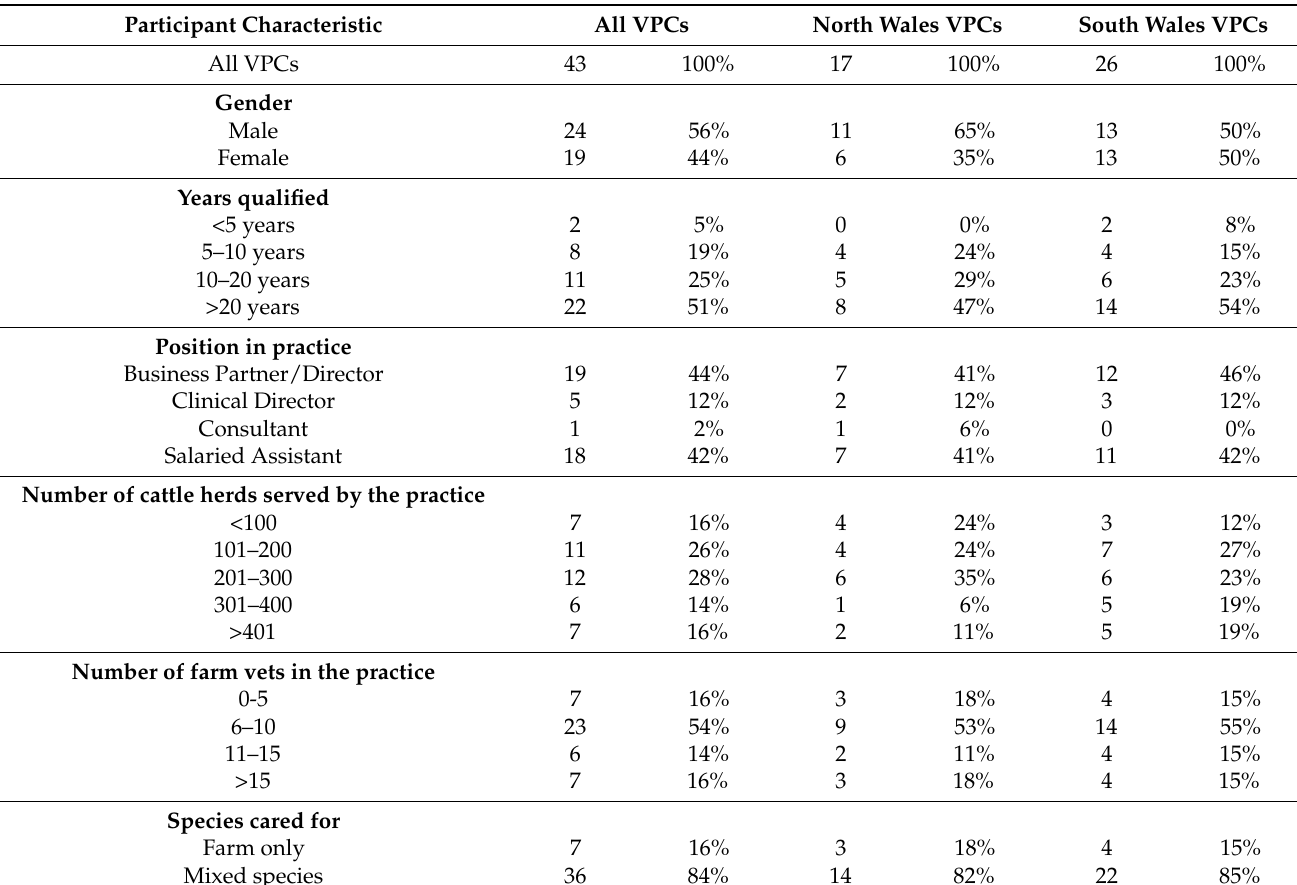
Table 2. Participant demographics of Veterinary Prescribing Champions (VPCs) enrolled on the Arwain Vet Cymru project in